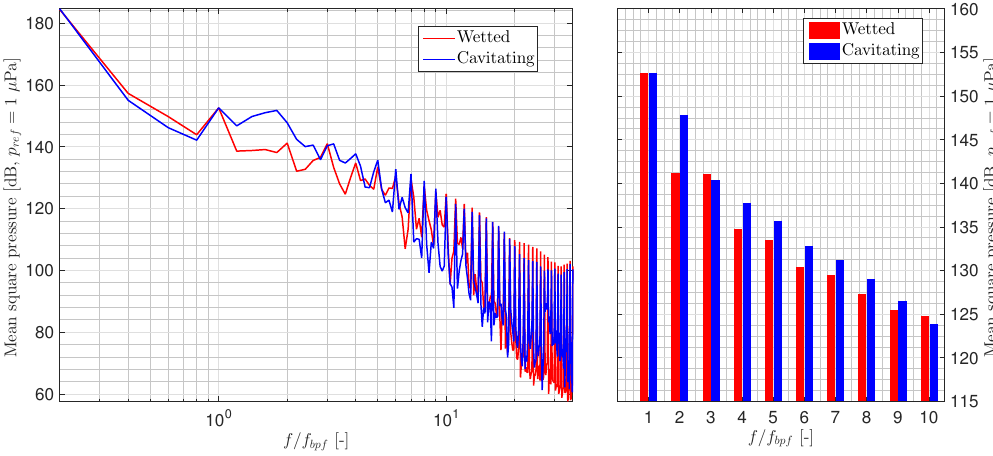
Figure 20. Simulated mean sound pressure levels inside the cavitation